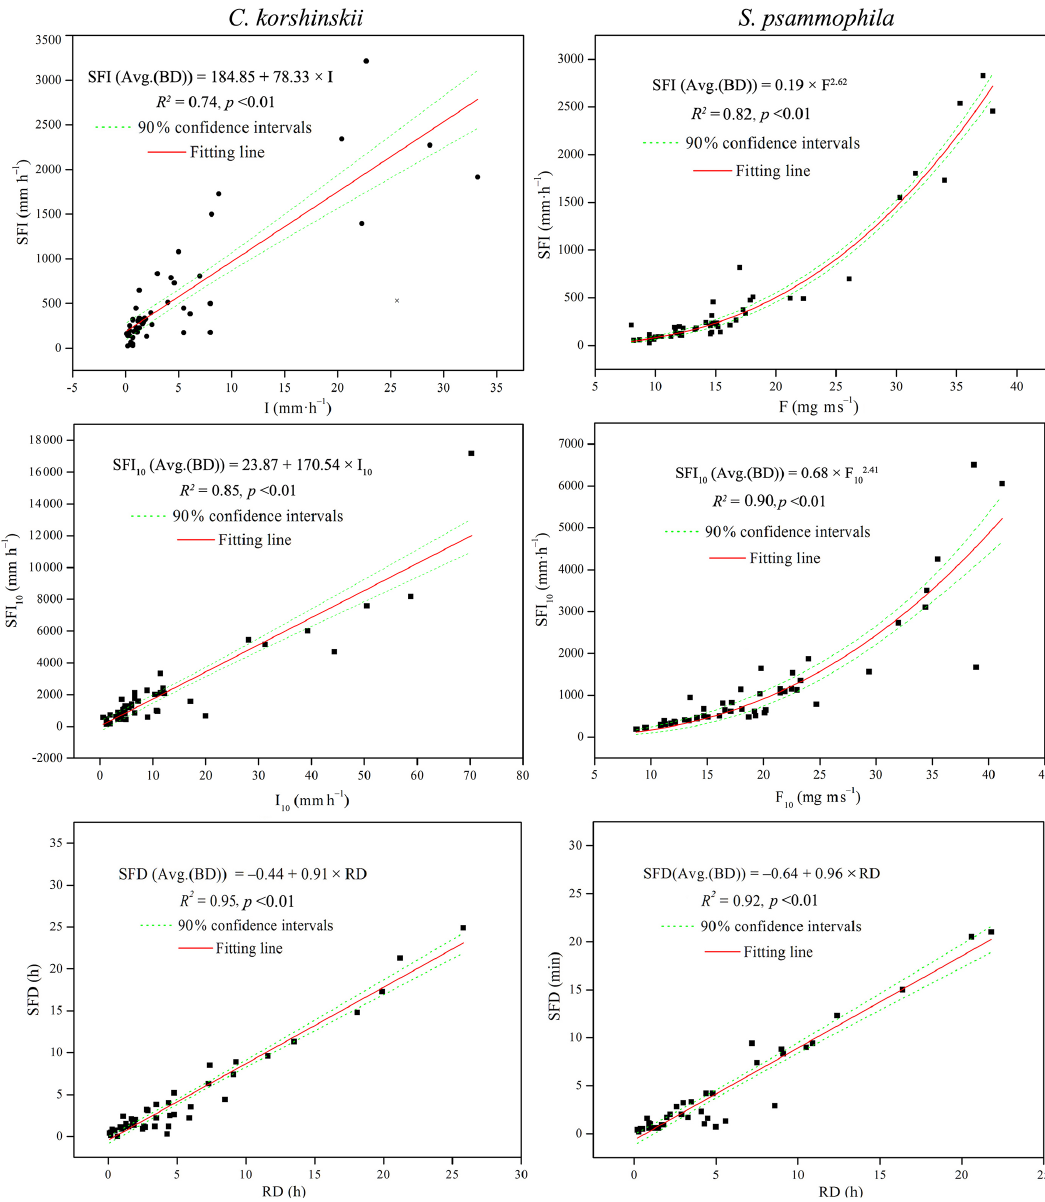
Figure 6. Relationships of stemflow intensity and duration with rainfall